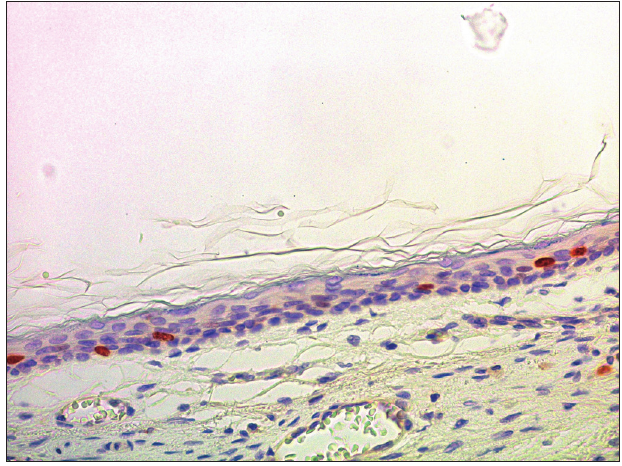
Figura 7. Fotomicrografia mostrando a epiderme da parede inferior do meato acústico externo com a presença de núcleos corados para Ki-67 na camada basal e na parte profunda camada espinhosa (IHQ – 400x).